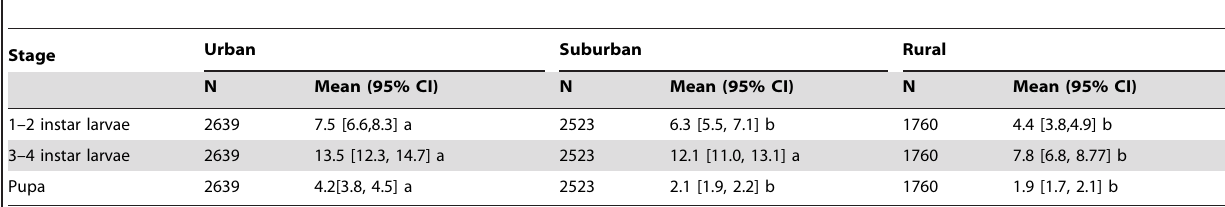
Table 2. Immature mosquito density at three sites (larvae per